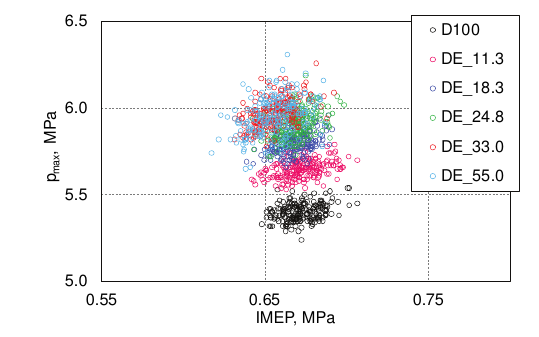
Fig. 11. Relationship of IMEP and p